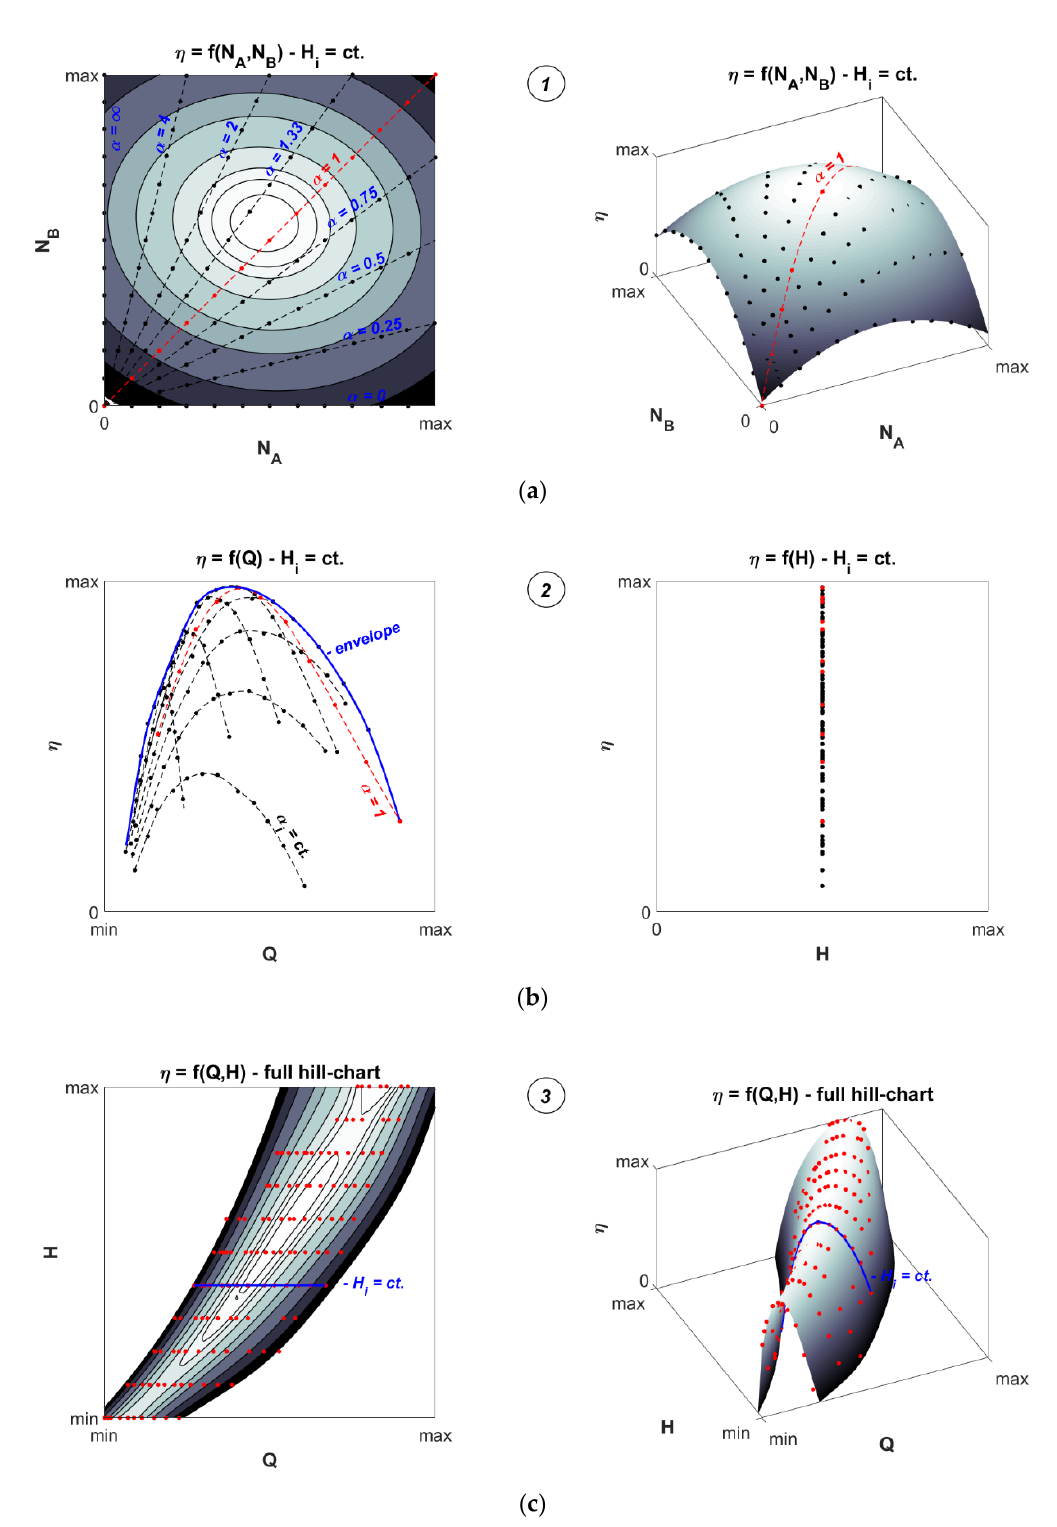
Figure 1. Standard methodology to reconstruct the full hydraulic efficiency hill-chart of a double-regulated machine using the classical static measurements method: ( a ) First step: measurements of several efficiency hill-charts at constant testing head H i and constant speed ratio between the two runners, α i ; ( b ) Second step: calculation of discharge-efficiency and head-efficiency envelopes for all testing heads; ( c ) Third step: construction of the final full 3D hill-chart of the machine by surface interpolation using the previously obtained envelopes.